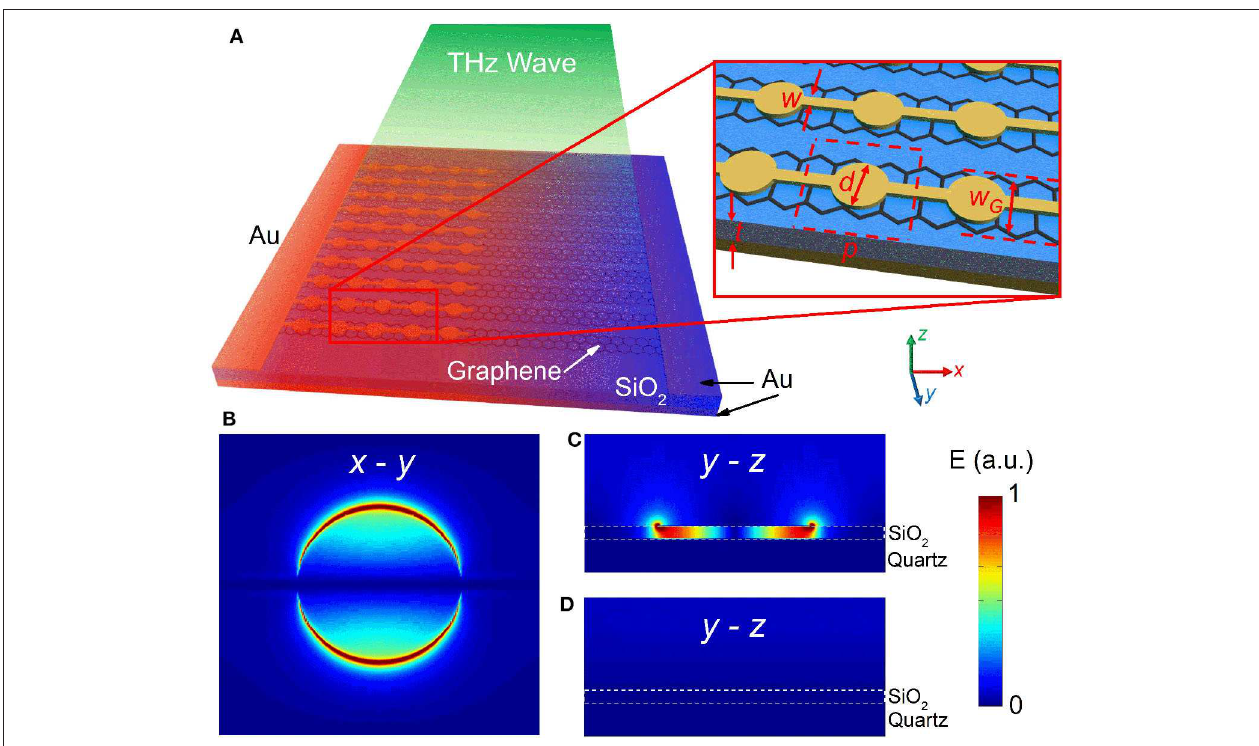
FIGURE 1 | (A) Schematic of the graphene device with a microstructured electrode. The inset shows the geometrical parameters of the microstructure. (B) The electric field distribution in the x - y plane (at the interface between the top Au layer and free space) and (C) in the y - z plane along the central axis as the LER occurs. (D) The y - z plane electric field distribution of the side without the LER